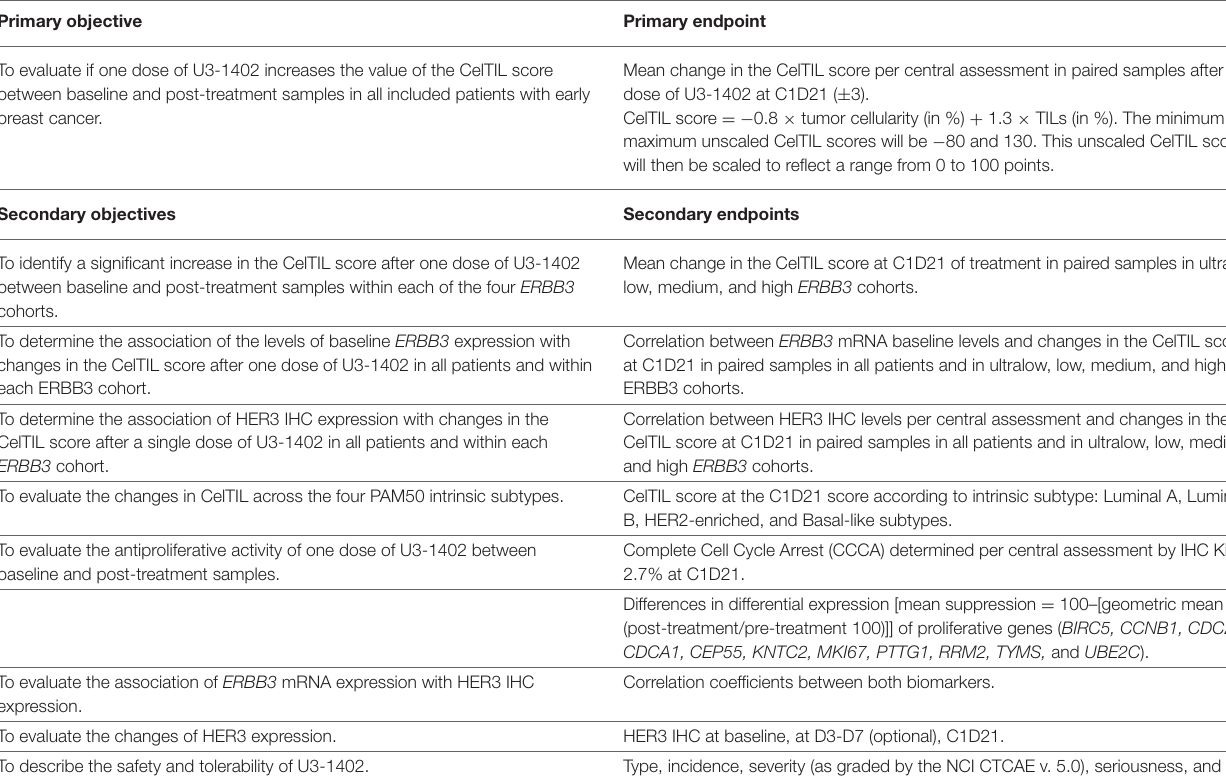
TABLE 2 | Primary and secondary objectives and